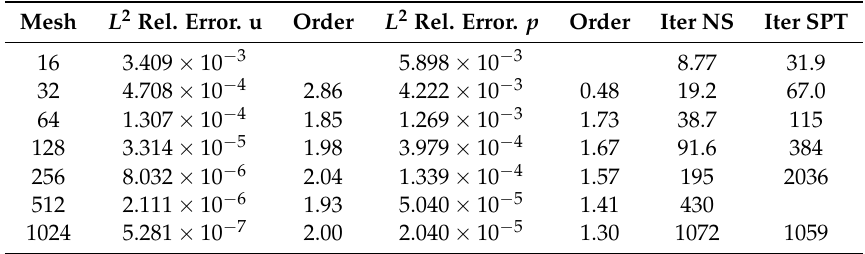
Table 1. L 2 relative errors in space and corresponding orders for the velocity and the pressure— rotational pressure-correction method with second-order correction.